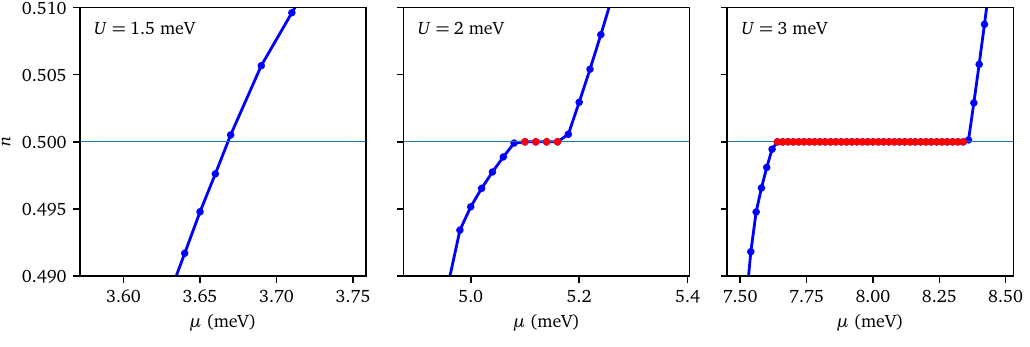
Figure 3: Electronic density vs chemical potential µ for different interaction strengths at quarter filling. The presence of a plateau (in red) is the signature of an insulating state, and the width of the plateau is the magnitude of the gap. The insulator-to- metal transition occurs between U = 1.5 meV and U = 2